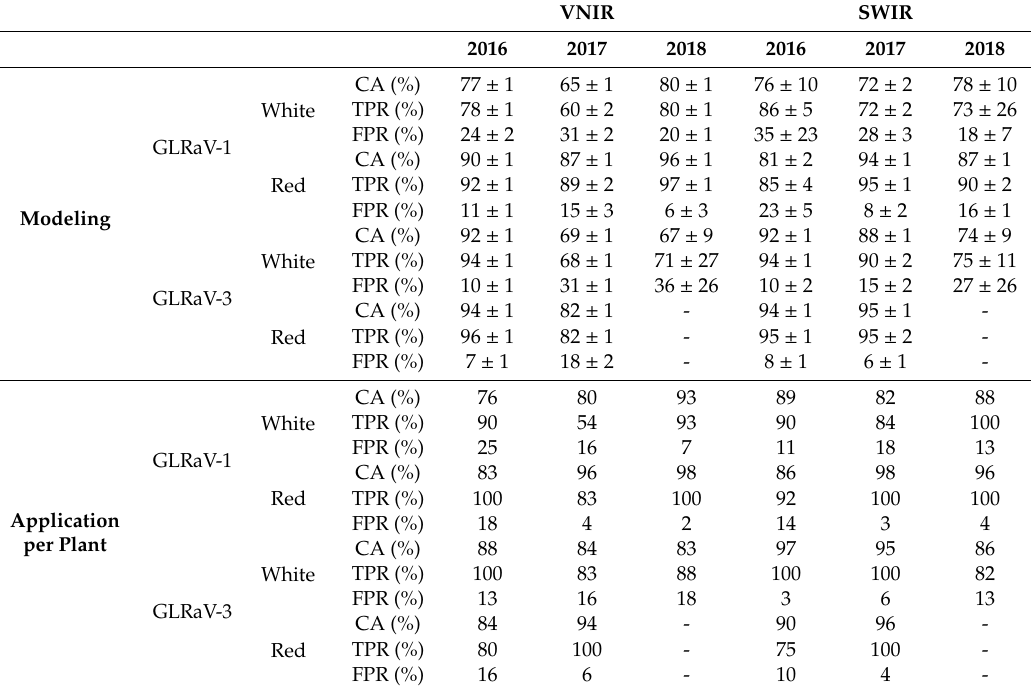
Table 9. Results for the in-field detection of GLRaV-symptomatic white and red cultivars. For modeling, all pixels were evaluated not considering spatial scales. Developed models were then applied per plant using all leaves for majority